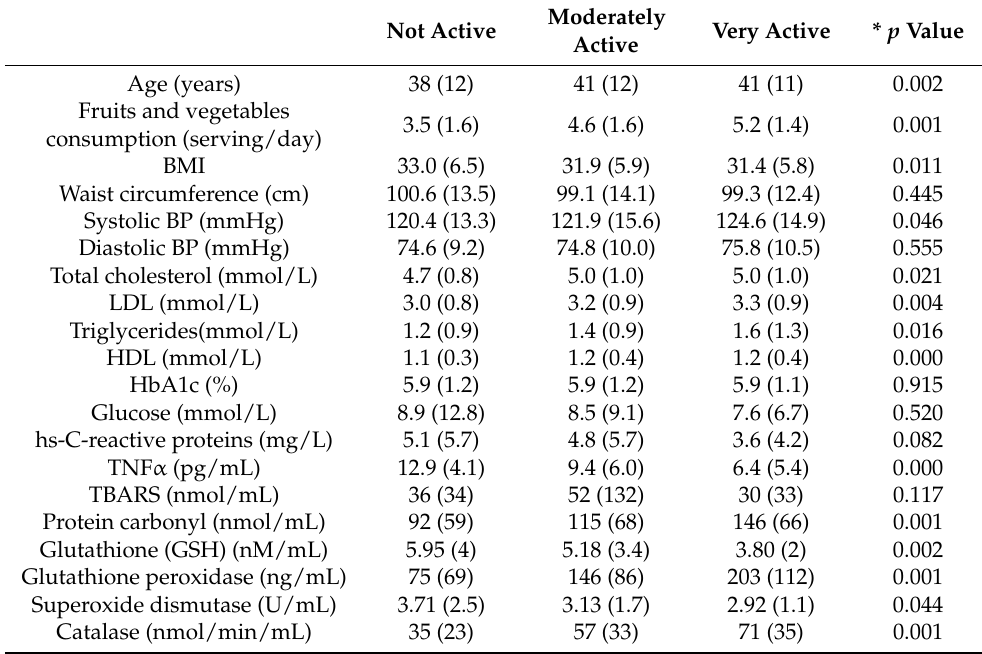
Table 3. Baseline anthropometric, BP, lipids, antioxidants and markers of oxidative damage and inflammation according to physical activity levels at leisure times, mean (SD), unless stated